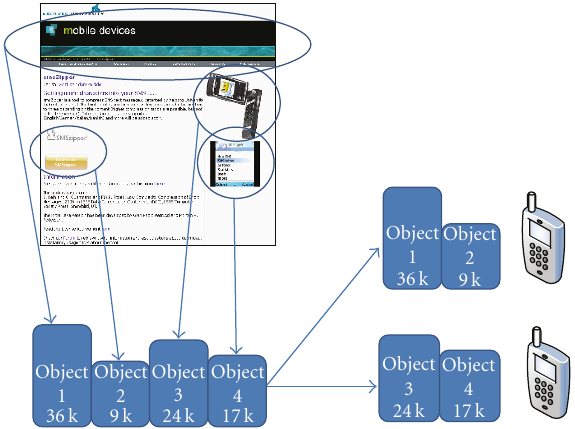
Figure 5: Web Page Processing Phase. This figure shows how the content of the web page is processed. All the components are classified and inserted into a list. The list is split into two sublists in such a way that the size of them is as much balanced as